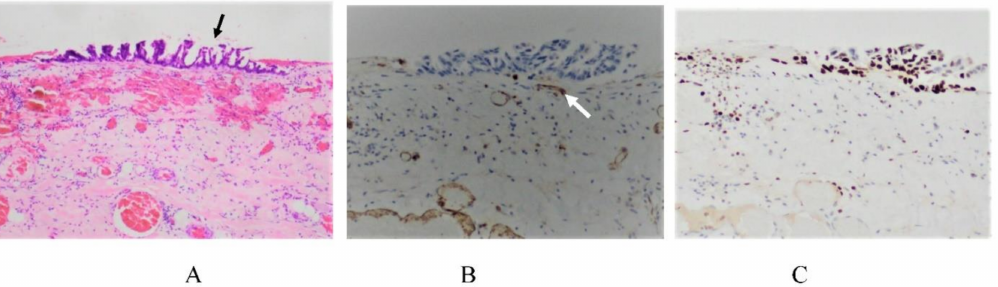
Figure 19. ( A ) Superficial growing metastasis. Micrometastasis of differentiated adenocarcinoma (arrow) growing on the paracolic gutter (HE staining). ( B ) CD31-positive submesothelial blood vessels (arrow) are detected just below the micrometastasis. ( C ) Ki67-positive cancer cells in the micrometastasis.